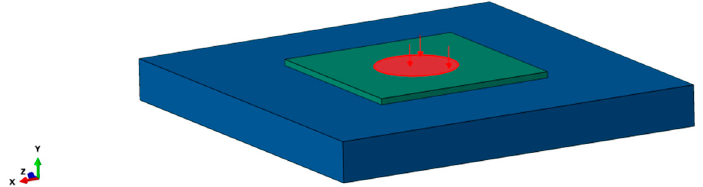
Figure 3. Area of the simulation model, in which the surface heat flux was applied (cp. Figure 2).